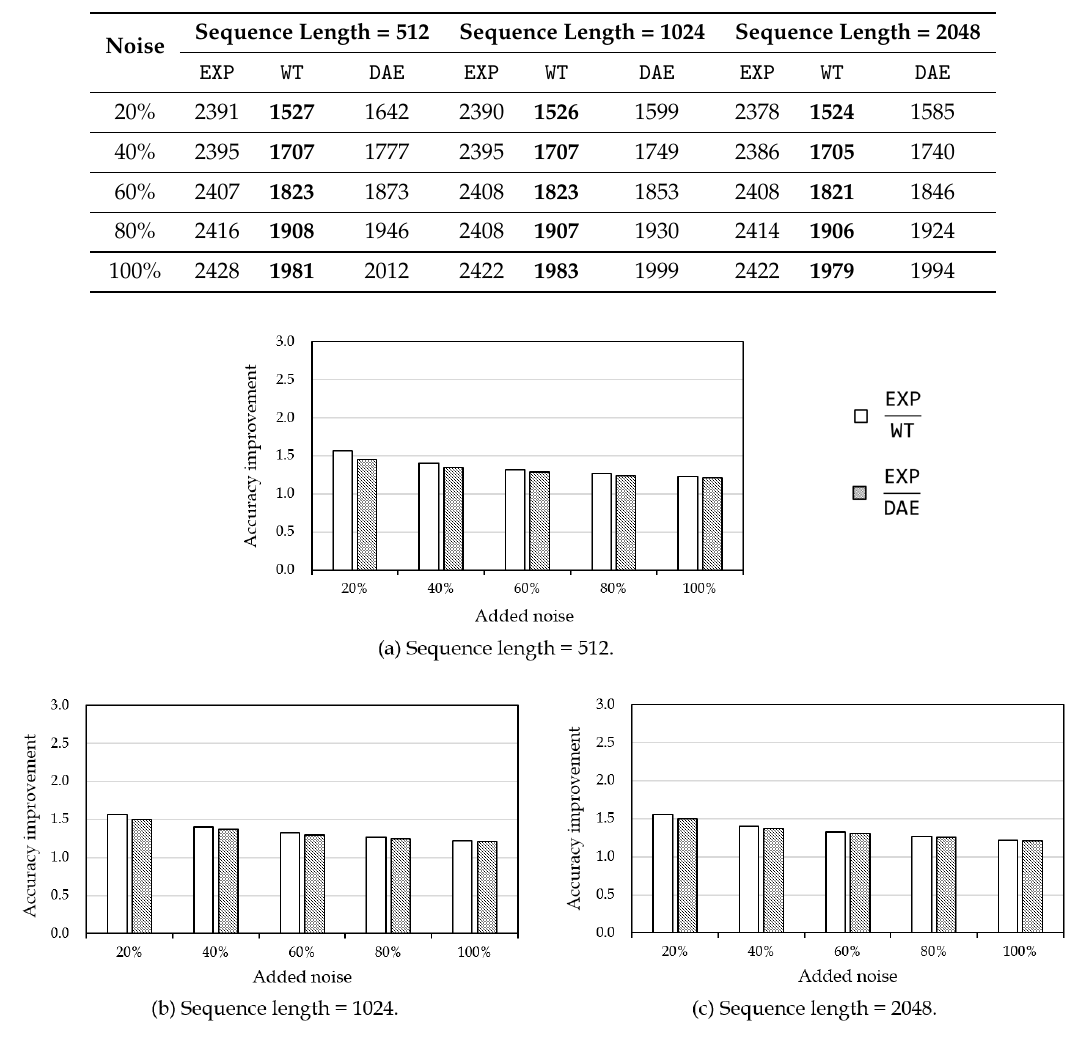
Figure 10. Filtering accuracy improvement on voltage data for different sequence lengths. The boldface numbers denote the best value in each